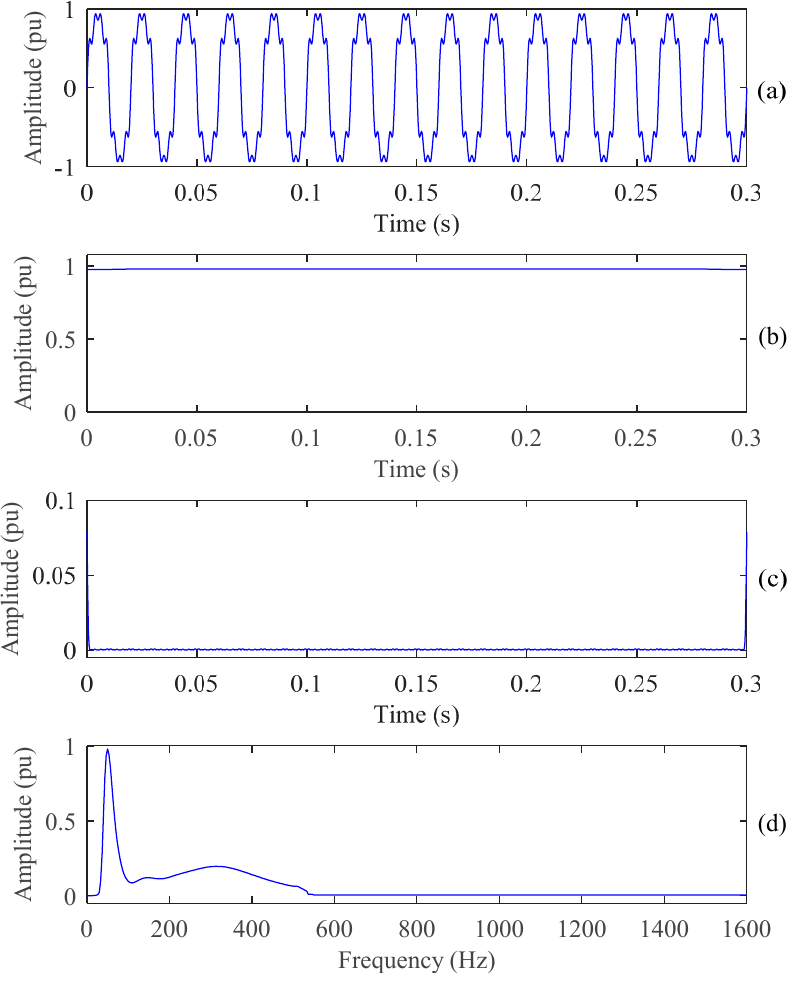
Figure 5. Voltage swell and related STA : ( a ) Voltage swell; ( b ) TvA ; ( c ) TvHFA ; ( d ) FvA. Case 5: The fourth disturbance is the harmonic; in this case, the harmonic and related STA plots are depicted in Figure 6. It can be observed from continuous ripples in the amplitude of TvA and TvHFA as shown in Figure 6b,c respectively. It is clear from Figure 6d that the amplitude of FvA value appears the high-level frequency and it can effectively be utilized to detect the harmonic .